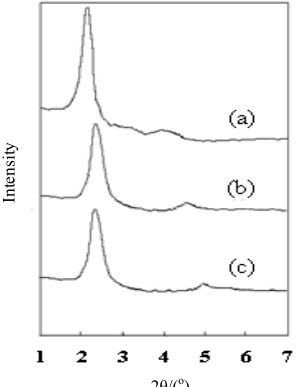
Figure 1. XRD patterns of (a) Al-MCM-41, (b) Co(acac) 2+ /Al-MCM-41.